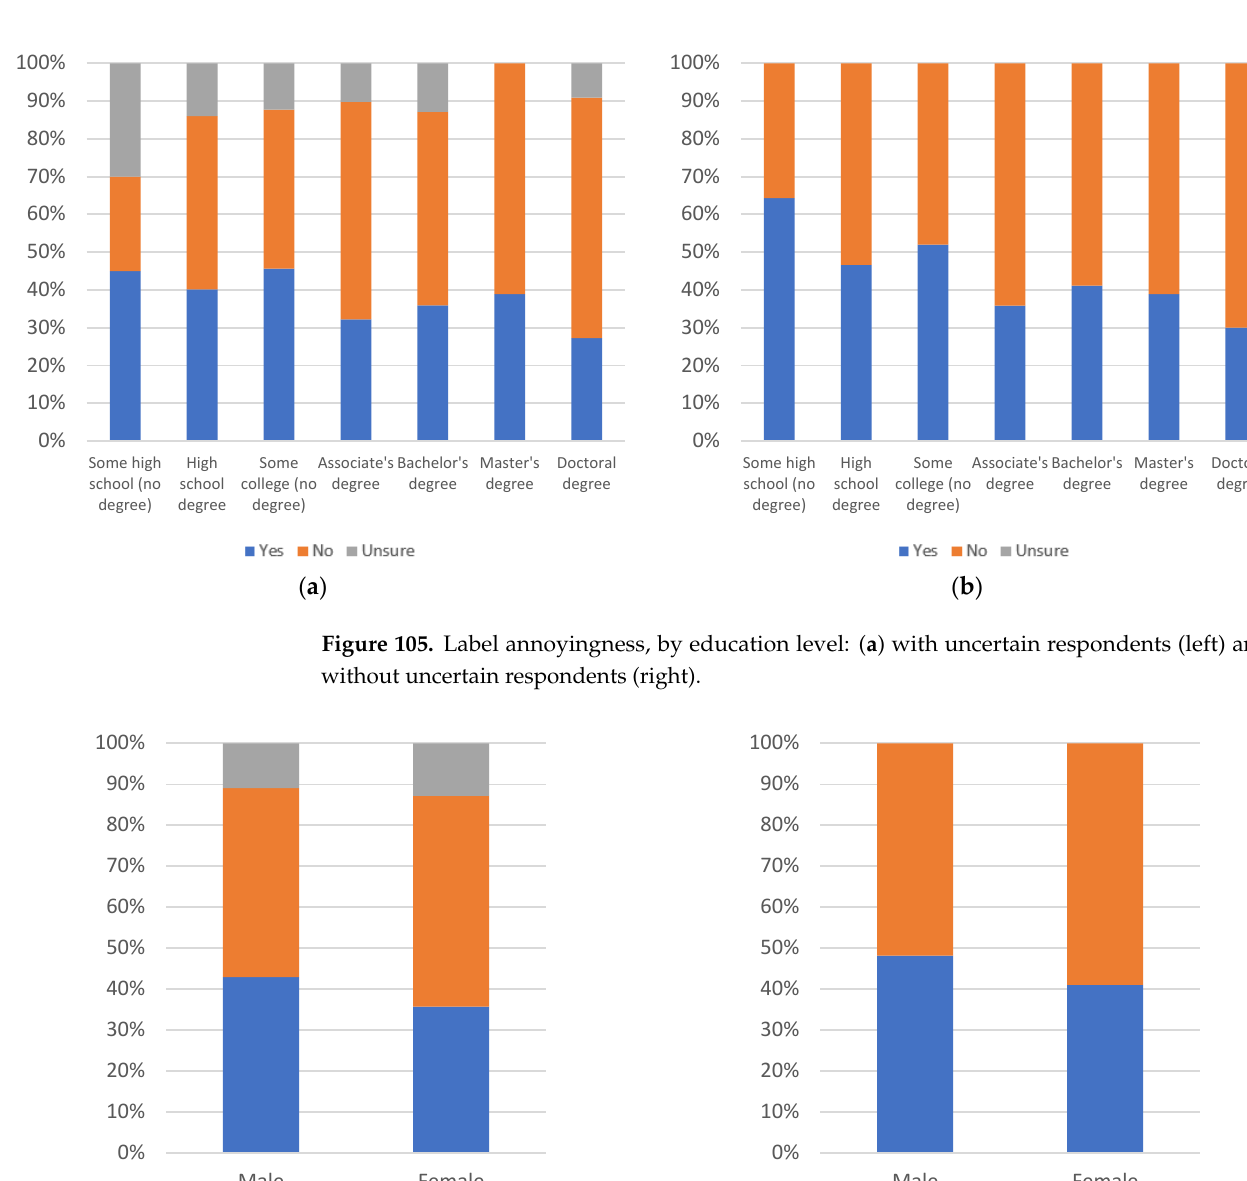
Figure 104. Label annoyingness, by age group: ( a ) with uncertain respondents (left) and ( b ) without uncertain respondents (right).